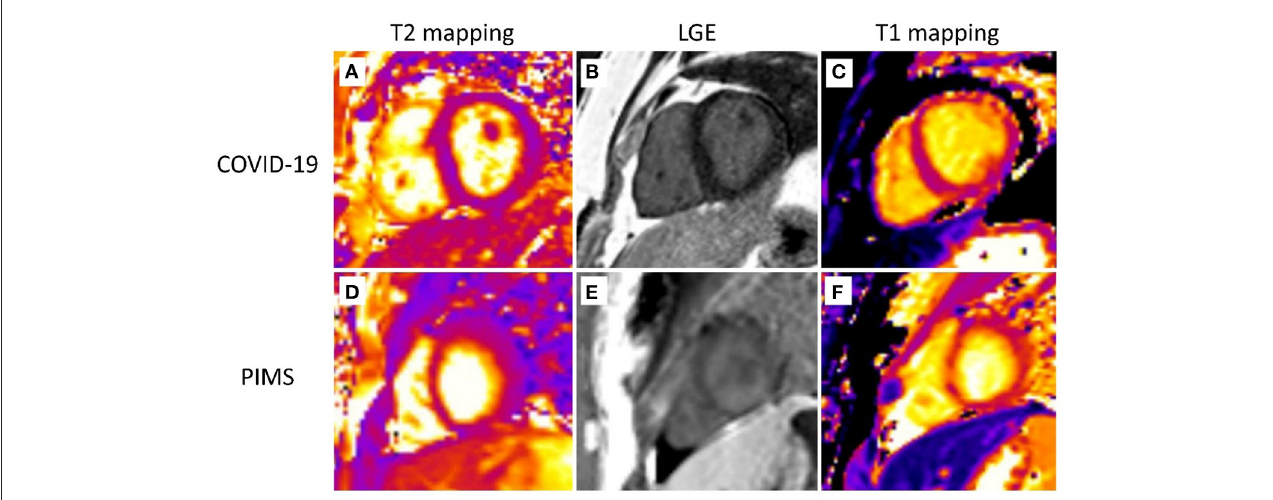
FIGURE1 Cardiovascular magnetic resonance. Representative cardiovascular magnetic resonance images are shown. The first row depicts a 15-year-old patient after severe COVID-19 infection. T2 mapping (A) , LGE (B) , and T1 mapping (C) images display subepicardial and intramural LGE and prolonged T1 relaxation (up to 1,200ms) along the anterior and anterolateral free wall of the LV with no signs of myocardial edema (normal T2 relaxation time- − 45–47ms). The second row shows images of an 11-year-old patient with pediatric multiorgan inflammatory syndrome (PIMS). T2 mapping (D) , LGE (E) , and T1 mapping (F) images display similar changes (subepicardial and intramural LGE and prolonged T1 relaxation up to 1,180ms with normal T2 relaxation time) with a slightly different distribution—along the lateral and posterolateral free wall of the LV.